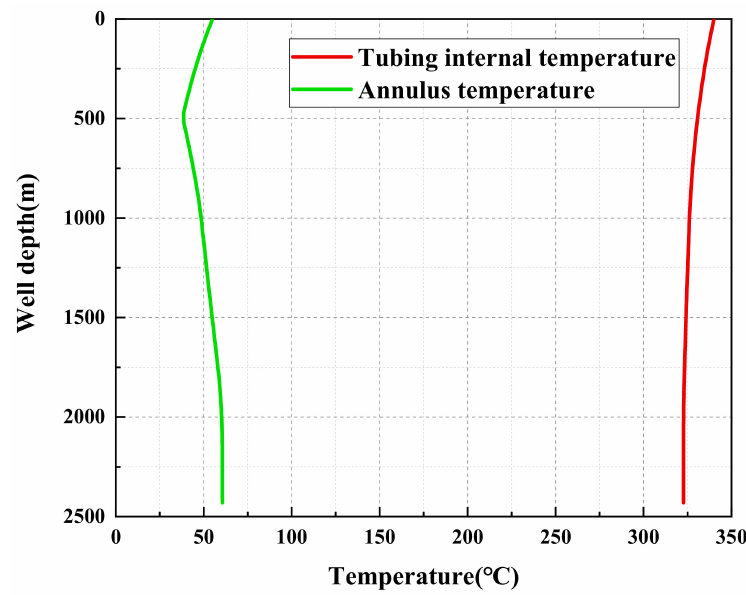
Figure 8. Temperature distribution of the integrated injection-production string.